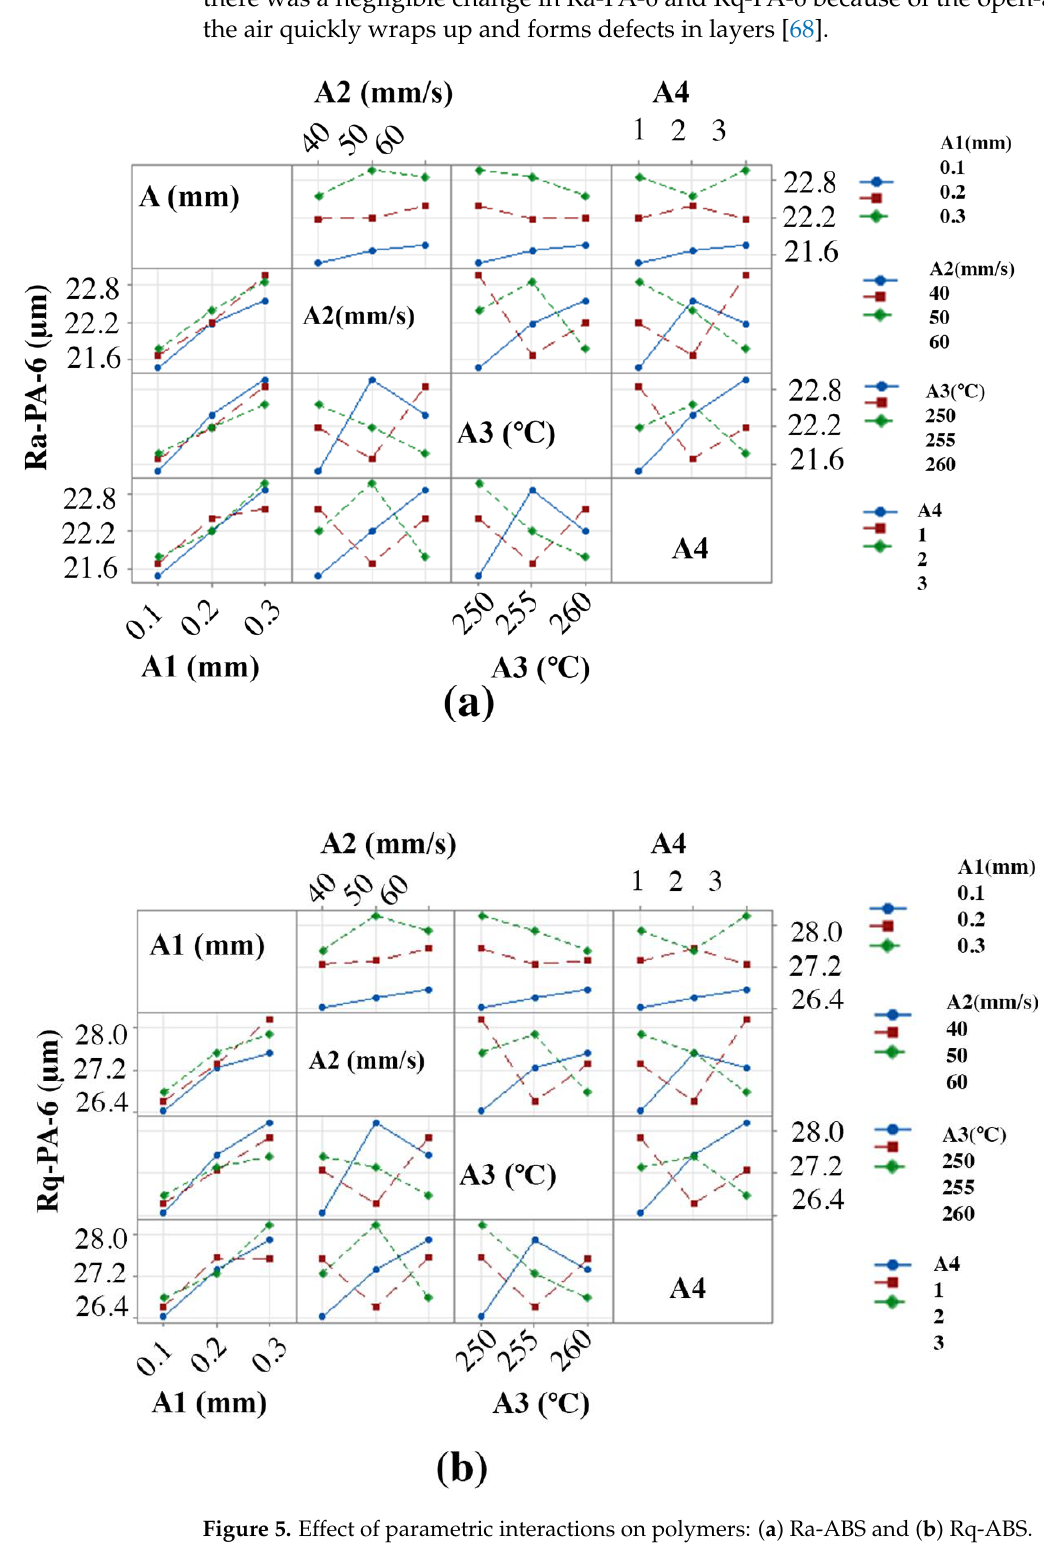
Figure 5. Effect of parametric interactions on polymers: ( a ) Ra-ABS and ( b ) Rq-ABS. Contour plots demonstrate the relationship between two control variables and a re- sponse variable by displaying the expected response va riables’ discrete contours. The con- tour plots in Figure 6 illustrate the relationship between the process parameters and the Ra-ABS value. The relationships of two most significant and two least significant factors were analyzed. According to Figure 6a, a low level of “G” and a low level of “F” resulted